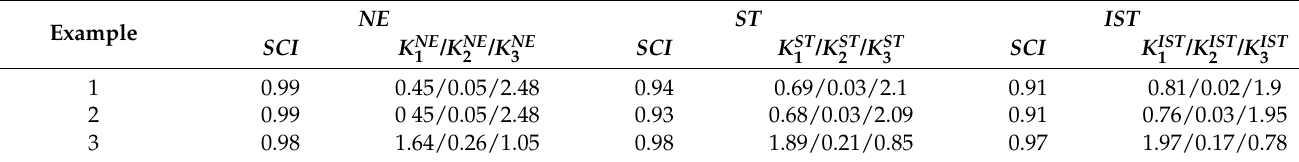
Table 5. Indices of relative efficiency for different information